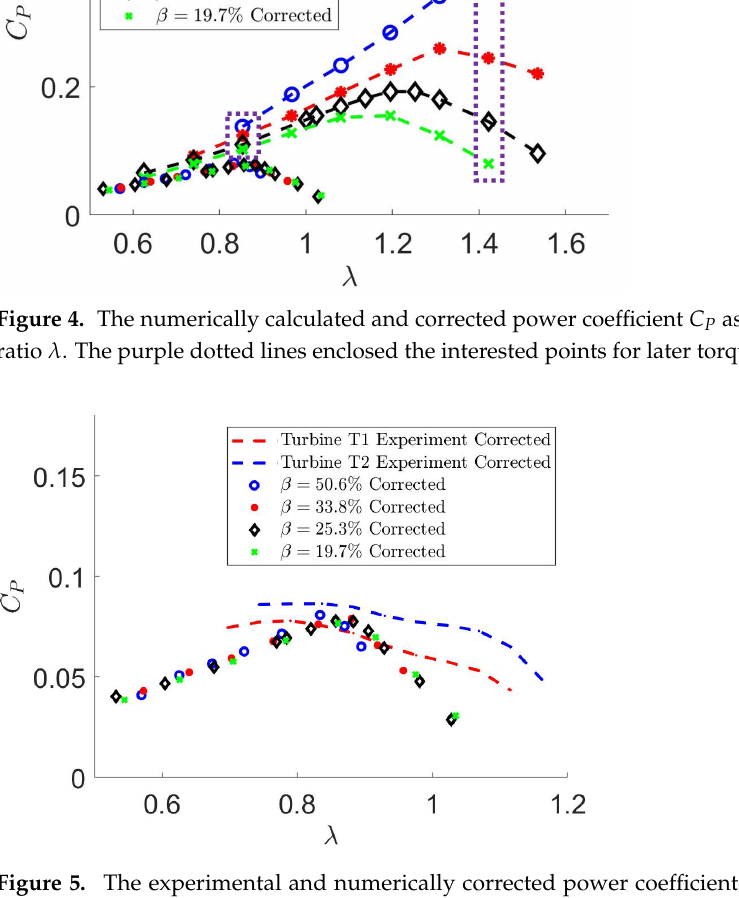
Figure 5. The experimental and numerically corrected power coefficient C P as a function of tip- speed-ratio λ at 4 blockage